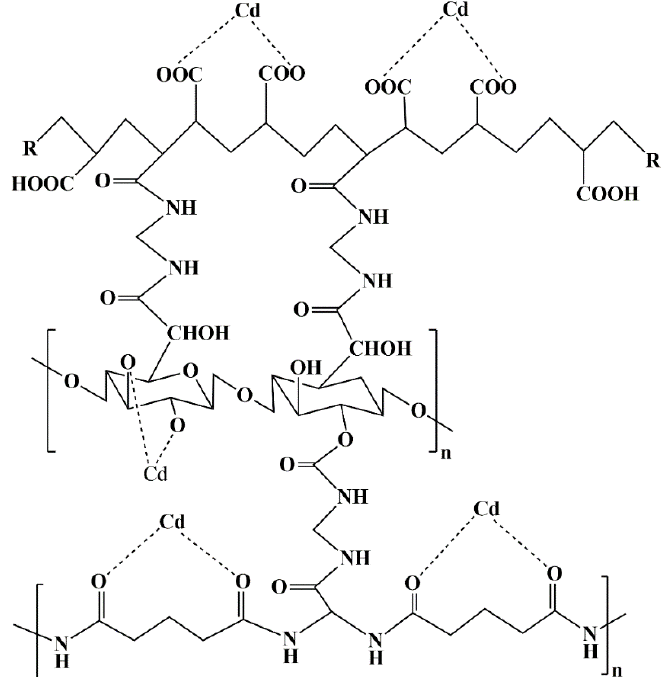
Scheme 1. Probable scheme for the complex formation by the adsorption of Cd(II) ions onto